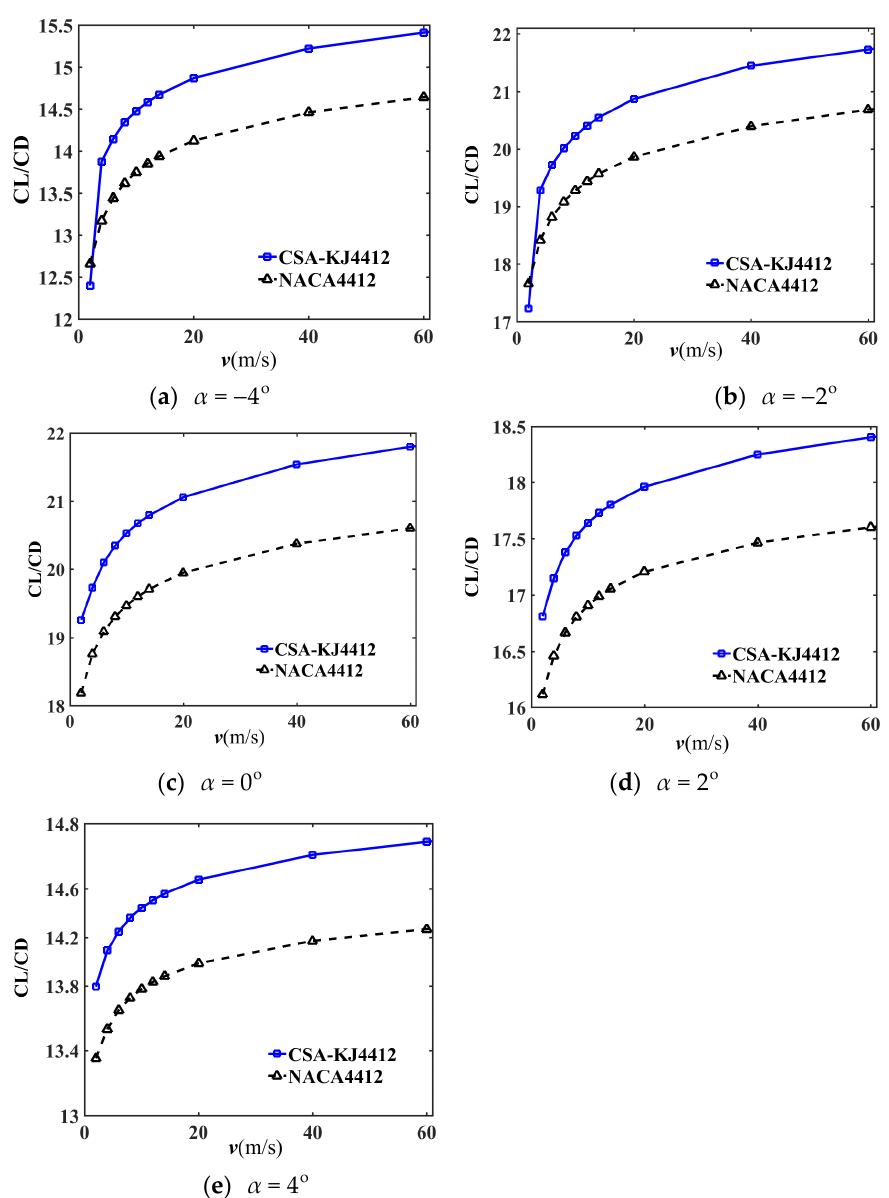
Figure 6. Variation of lift-drag ratio coefficient with incoming wind speed under different angles of attack.